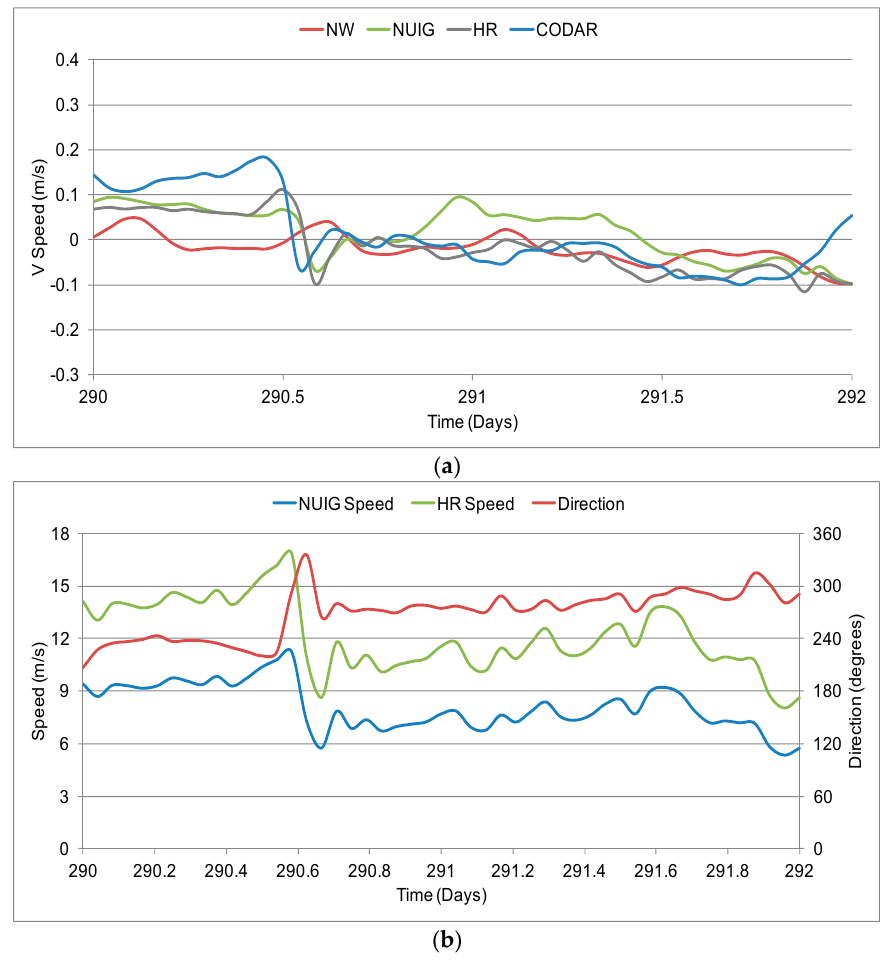
Figure 19. Modeled and measured north-south surface velocity component at C3 (( a ) north-south surface velocity components; ( b ) modeled wind speeds and direction at C3).